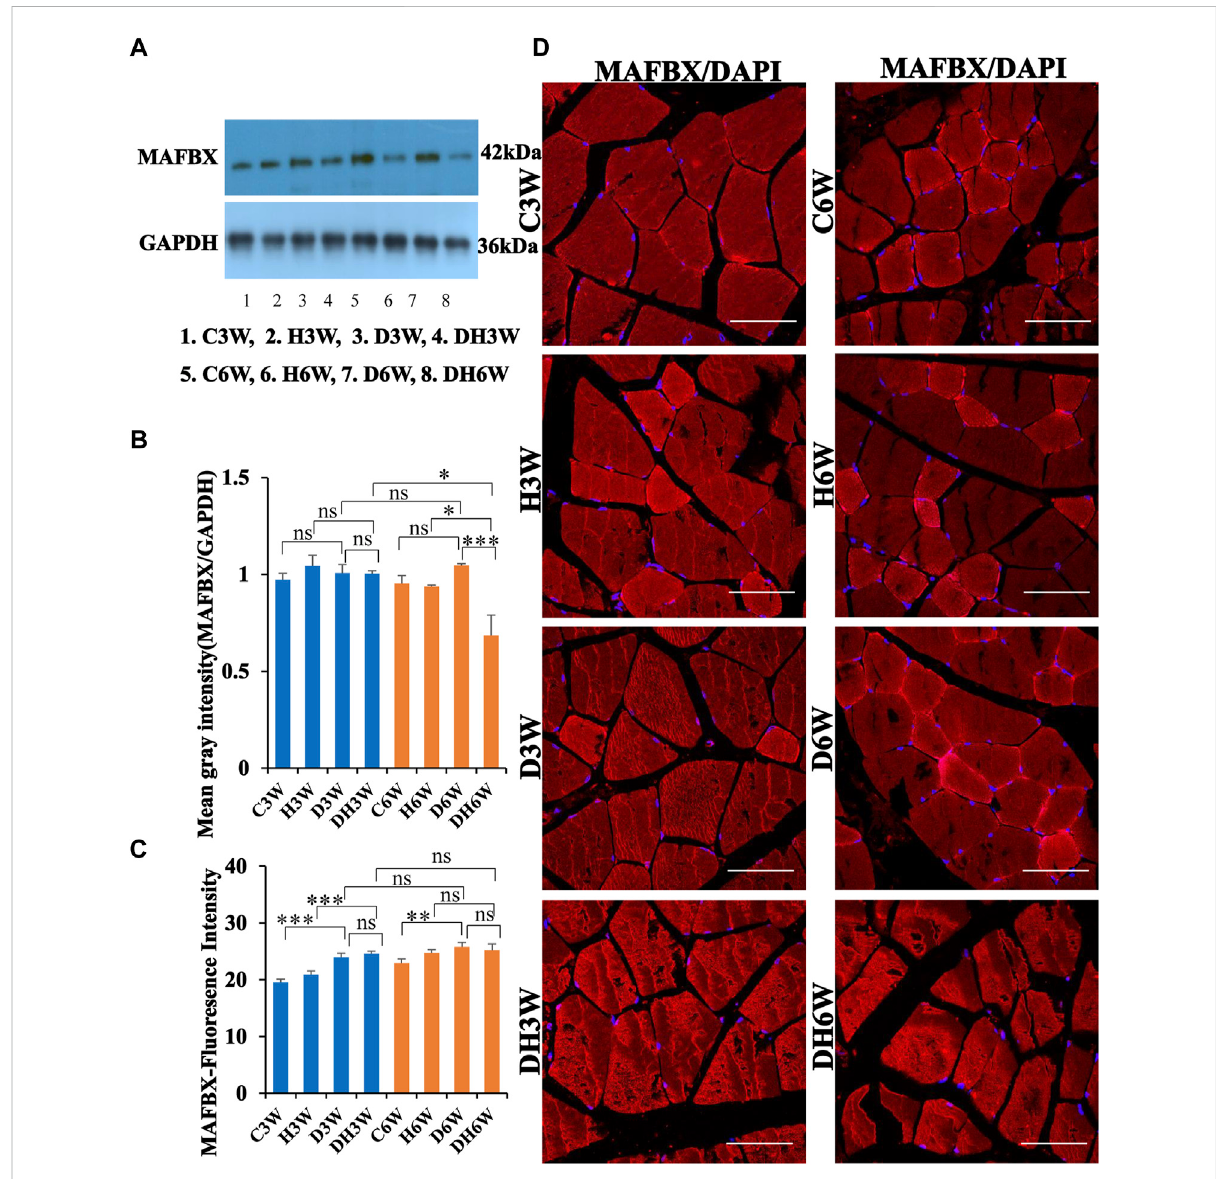
FIGURE 9 (A,B) Immunoblots probed with anti-MAFBX antibody (A) and mean gray intensity of immunoblots (B) . There were no signi fi cant differences in the expression of MAFBX (mean gray intensity) between groups in short term experiment. However, it was decreased signi fi cantly in DH6W compared to D6W and signi fi cantly less compared to DH3W. (C,D) MAFBX immuno fl uorescence intensity (C) and representative cross-section of muscle fi bers stained for anti-MAFBX immuno fl uorescence in short-term (left panel) and long-term (right panel) experiments (D) . Immuno fl uorescence data showed signi fi cantly increased fl uorescence intensity of MAFBX in D3W and D6W compared to C3W and C6W respectively. Therewasnosigni fi cantdifference inMAFBXexpression fromshort-term(D3WandDH3W)tolong-term (D6WandDH6W).Notelarge number of muscle fi bers showing immuno fl uorescence in D3W, DH3W, D6W, and DH6W (*, p < 0.05; **, p < 0.01; ***, p < 0.001, One-way ANOVA, Bonferroni multiple comparison tests, n = 6 in all groups). Scale bar = 50